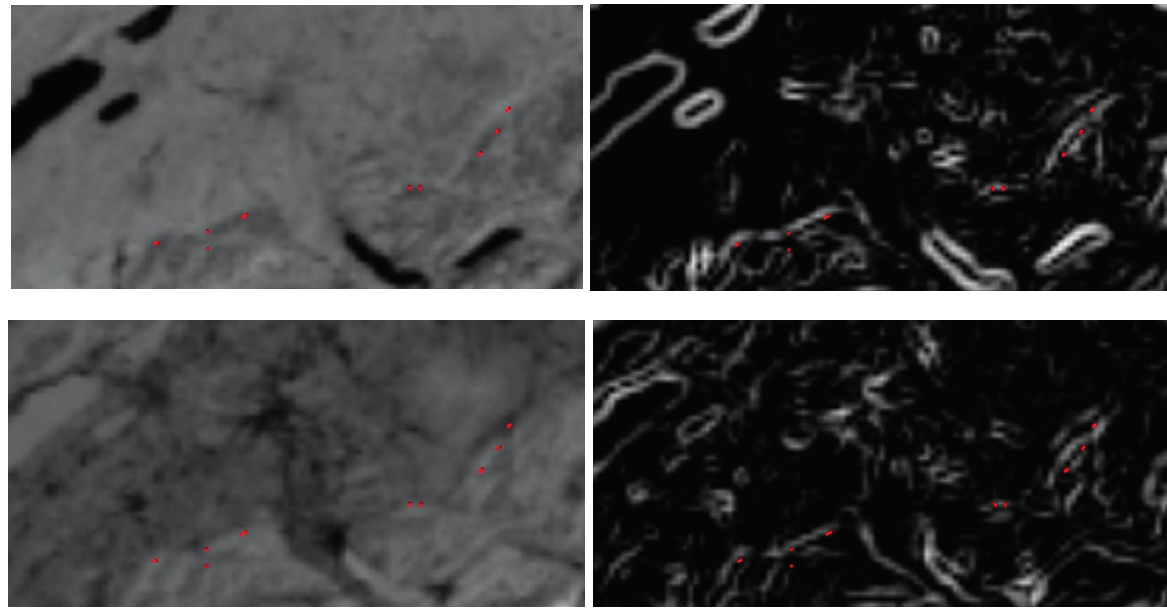
Figure 5. AVHRR Band-1, 5, and 3A images acquired from Metop-A on 23 January 2008 and the cloud mask used in the matching.